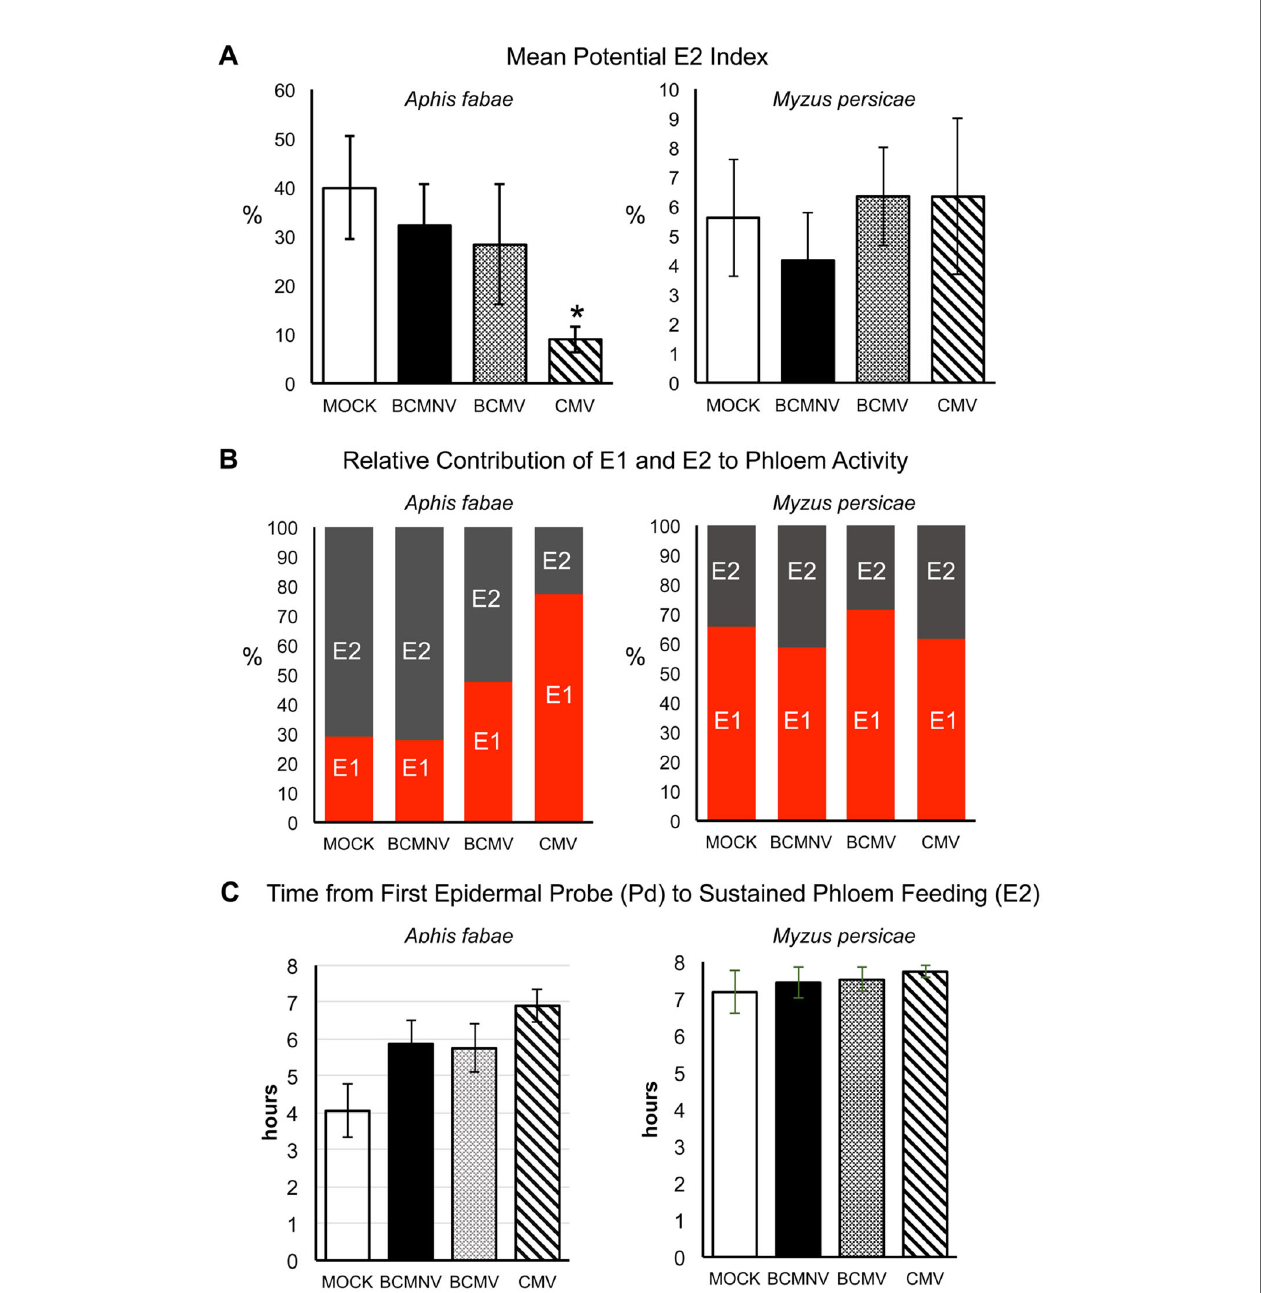
FIGURE 4 | On common bean Myzus persicae is less likely than Aphis fabae to ingest phloem sap and its phloem feeding activity is less affected by plant infection status. (A) Using EPG data the likelihood (as percentage odds) of an aphid transitioning to sustained phloem sap ingestion (the potential E2 index, PEI) was determined by beta GLM with the multcomp package in R (Hothorn et al., 2009) for A. fabae and M. persicae placed on mock-inoculated plants or plants infected with bean common mosaic virus (BCMV), bean common mosaic necrosis virus (BCMNV), or cucumber mosaic virus (CMV). Sustained phloem feeding in this case is indicated by periods of E2 waveform activity of >10 min. (A) As shown by the PEI, A. fabae was markedly more likely to ingest phloem sap from mock-inoculated plants than M. persicae (which appears to fi nd common bean an unsuitable host) but the likelihood of phloem feeding was diminished for A. fabae on virus-infected plants and was signi fi cantly decreased on CMV-infected plants ( p = 0.040). Virus infection status had no effect on the already low likelihood of phloem feeding by M. persicae . (B) On plants infected with BCMV and CMV but not with BCMNV, the proportion of time spent by A. fabae in salivation into the phloem (waveform E1) relative to sap ingestion (waveform E2) increased markedly. The proportion of time M. persicae spent salivating into or feeding from the phloem appeared unaffected by plant infection status. (C) EPG recordings of A. fabae on mock-inoculated plants showed sustained phloem feeding began by 4-h post-placement while A. fabae placed on plants infected with BCMV, BCMNV, or CMV took on average 5.8, 5.7, and 6.9 h, respectively. In all panels error bars represent standard error of the mean. The asterisk denotes a signi fi cant difference in feeding behavior between insects on virus-treated and mock-inoculated plants (Dunnett test, p < 0.05: see Supplementary Table 3 for